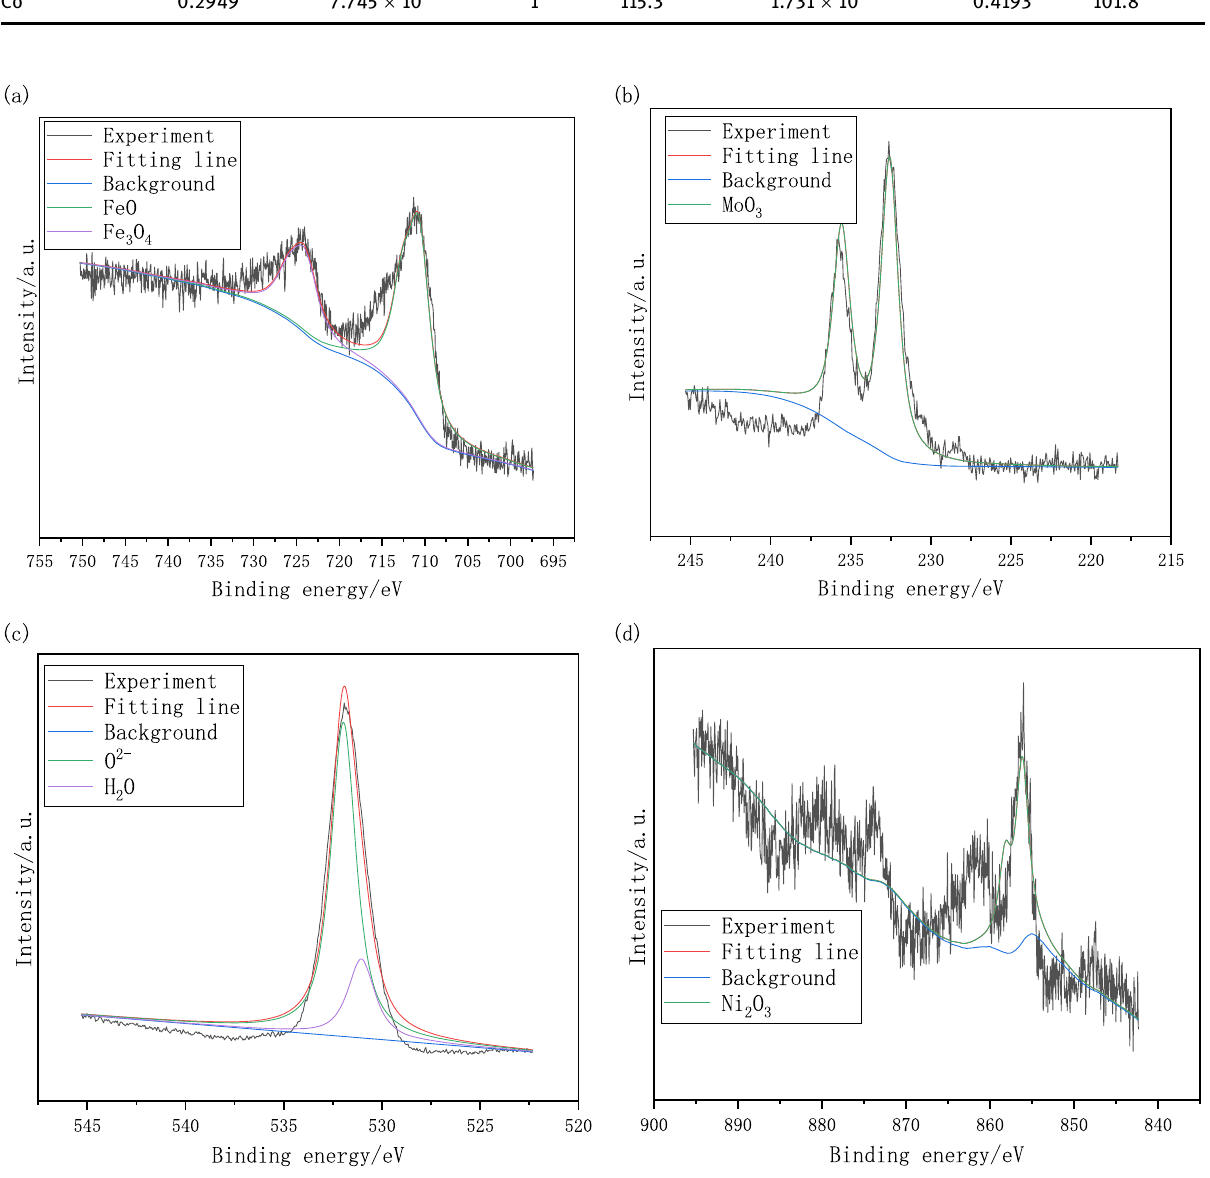
Figure 9: Fe ( a ) , Mo ( b ) , O ( c ) and Ni ( d ) high resolution XPS spectra of passive fi lm of Ni + 15% WC coating exposed to 0.5 mol · L − 1 HCl solution for 30